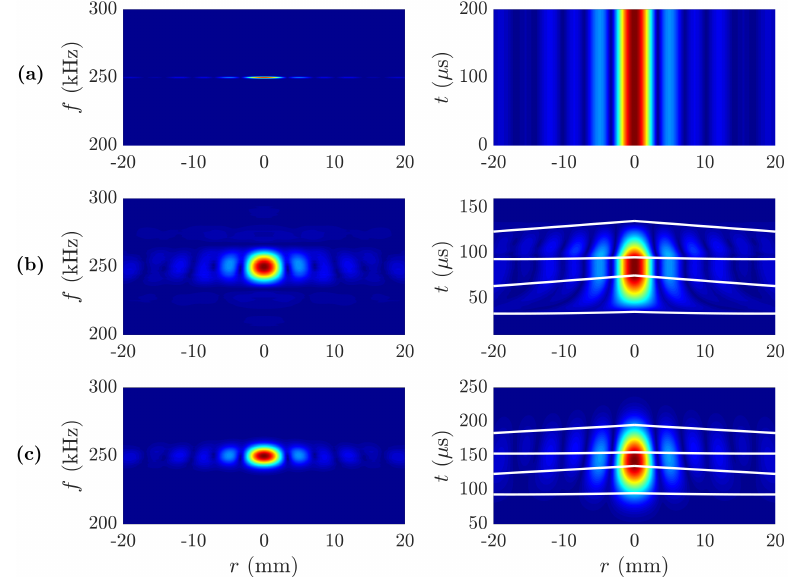
Figure 4. Transversal focusing profile spectra | P ( r , f ) | (left) and transient focusing profile | P ( r , t ) | (right): ( a ) Continuous Wave, ( b ) Modulated Rectangular Pulse, and ( c ) Modulated Gaussian